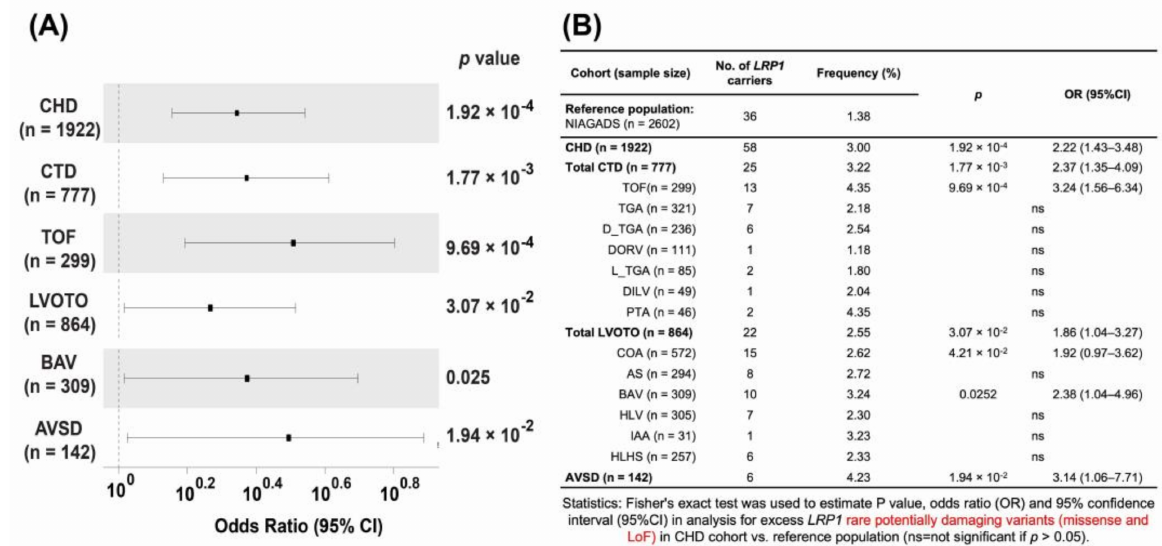
Figure 5. Rare LRP1 damaging variants are associated with different congenital heart defects. ( A ) Compared with normal controls, LRP1 damaging variants are associated with different CHDs, including conotruncal defect (CTD), Tetralogy of Fallot (TOF), left outflow tract obstruction (LVOTO), bicuspid aortic valve (BAV), and atrioventricular septal defect (AVSD). The odd ratio (OR) and 95% confidence interval (CI) are shown. The total number of affected individuals analyzed is indicated. ( B ) The statistical analysis compared with LRP1 rare potential damaging variants with different congenital heart defects using the normal control from ADSP/NIAGADS [28] as a control